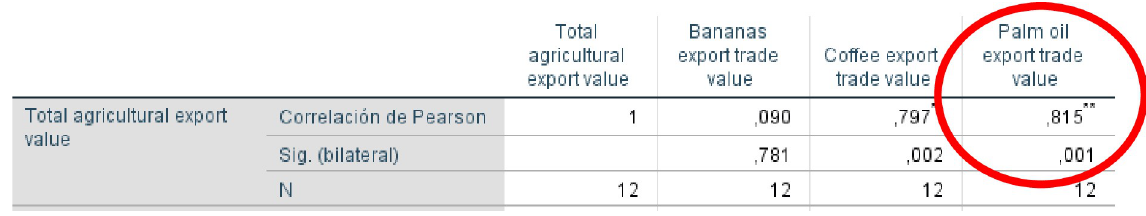
Fig 6. Correlation of agriculture commodities trade value. Source: Own calculations.